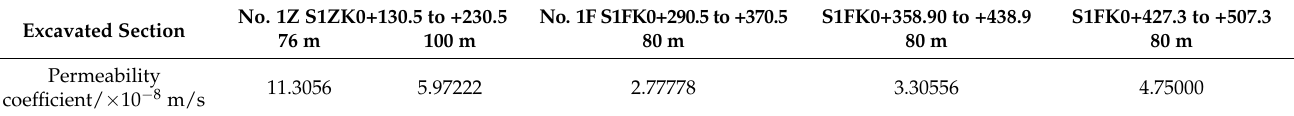
Table 25. Values of permeability coefficients for different excavation